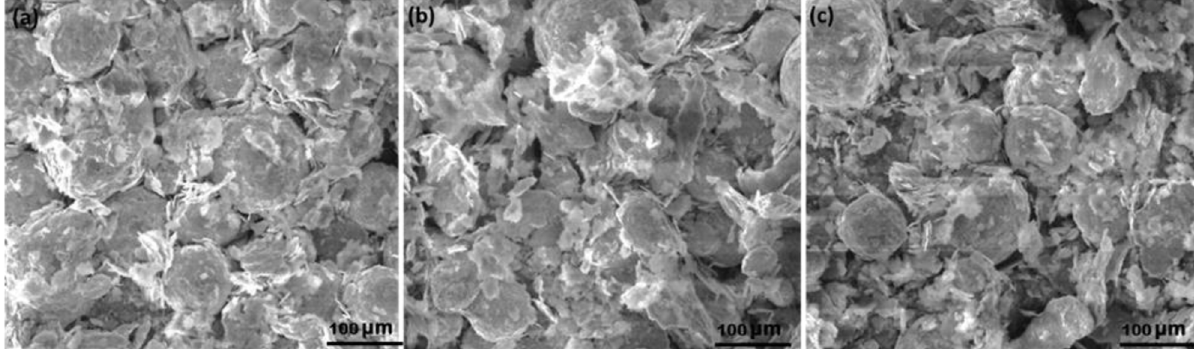
Fig. 2. SEM images of the milled NAB powders which consist of Aluminium (a) 6 wt.%, (b) 8wt.%, and (c) 10 wt.%.